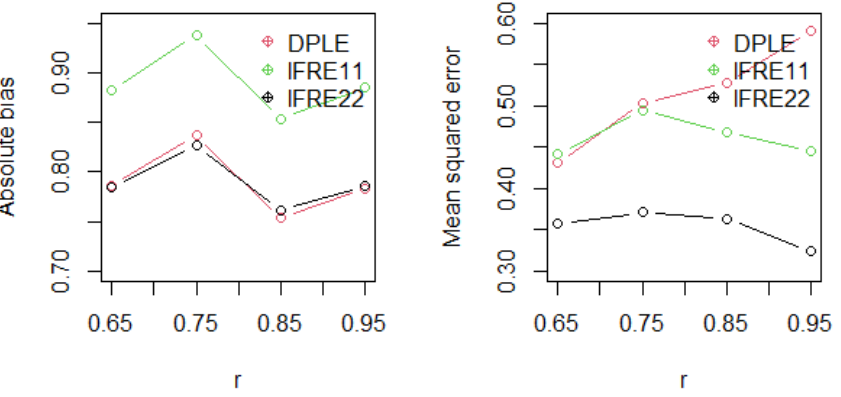
Figure 2. Plots of the bias and MSE for four different scenarios which combine a fixed sample size n = 40 with a variational correlation coefficient obtained by DPLE, lFRE11 and lFRE22.